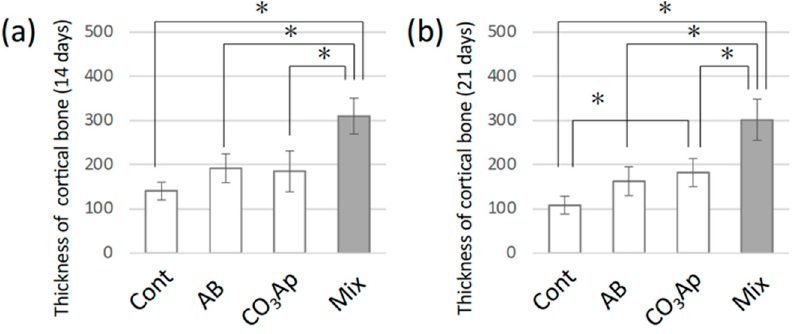
Figure 4. Thickness of the injured bone ( a ) 14 days and ( b ) 21 days after surgery (* p < 0.05) for the control group (Cont), autogenous bone group (AB), carbonate apatite group (CO 3 AP), and AB and CO 3 AP mixed group (Mix).